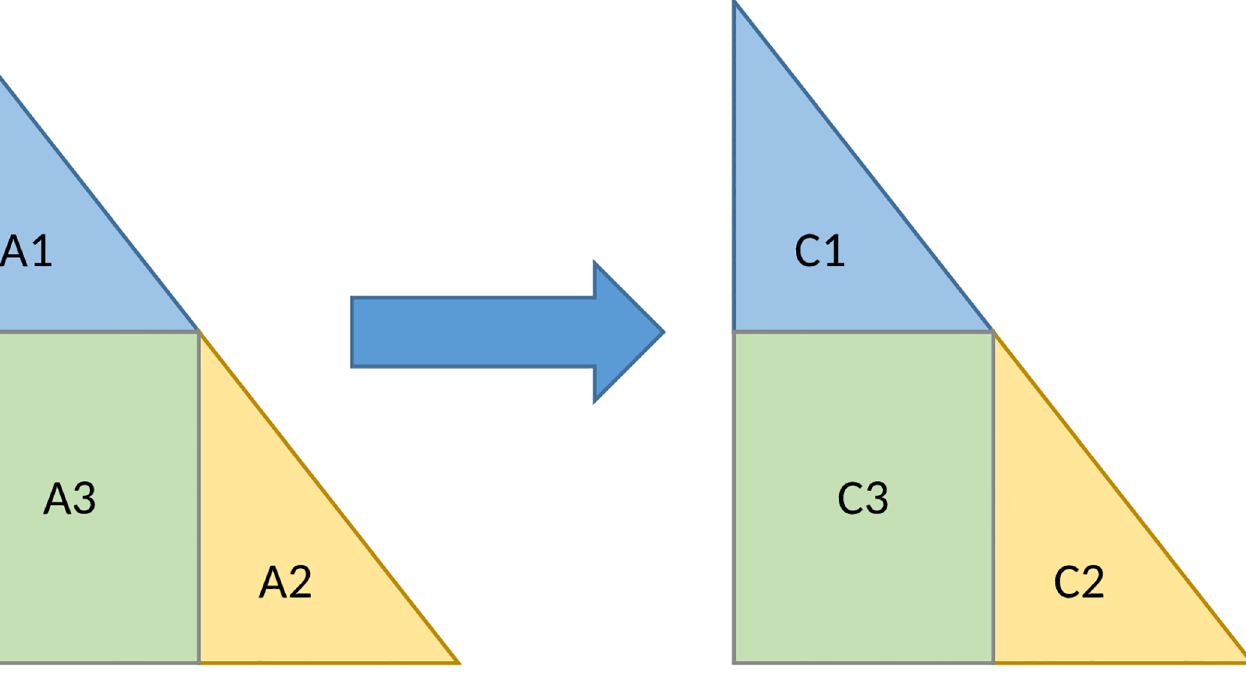
Fig 2. The split of the lower triangular matrix inverse.